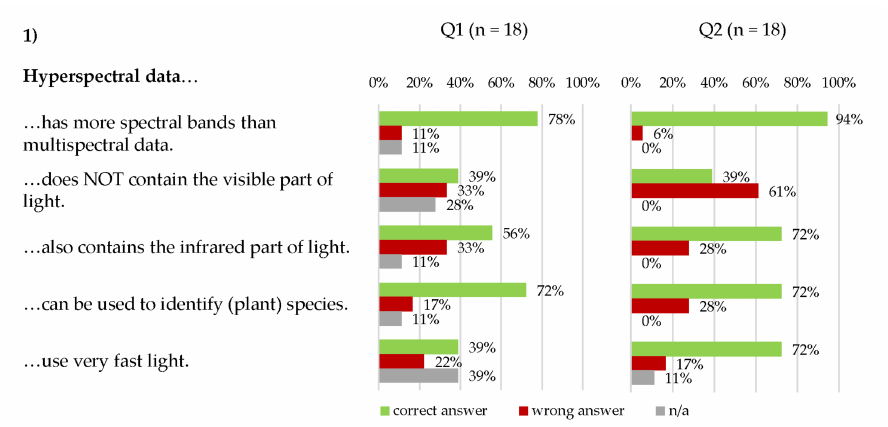
Figure 17. Answers from both test groups about the properties of hyperspectral